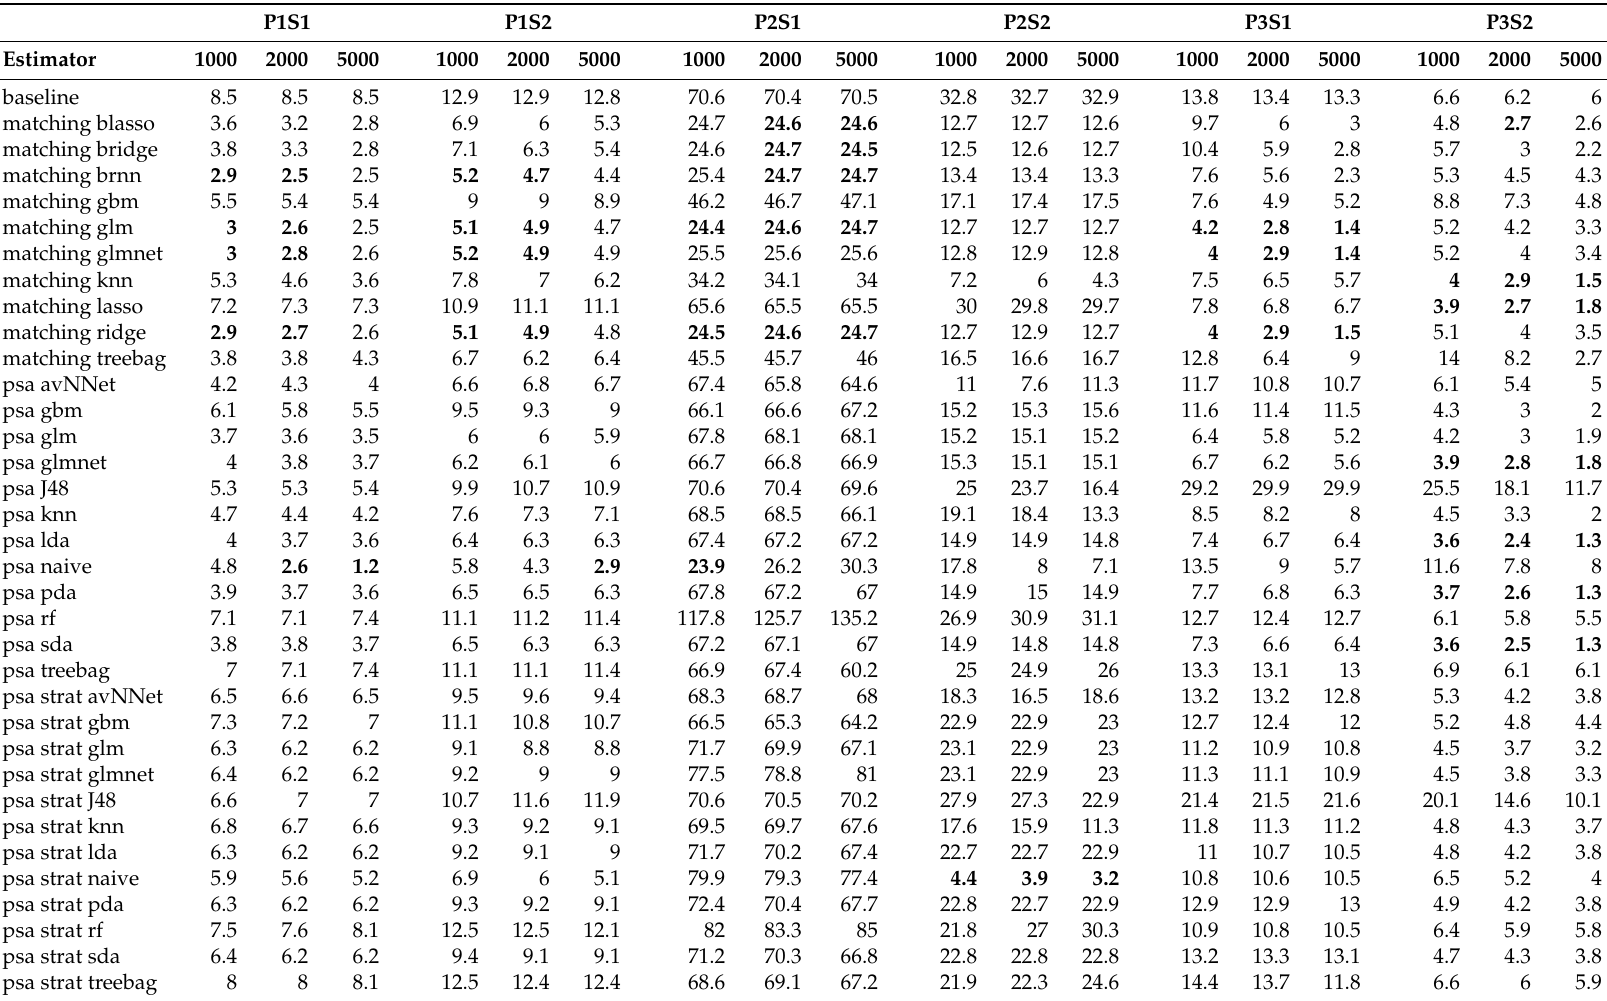
Table A3. Relative Root Mean Square Error (RMSE) (%) of each estimator for each population, sampling method, and sample size. The best values among the methods are shown in